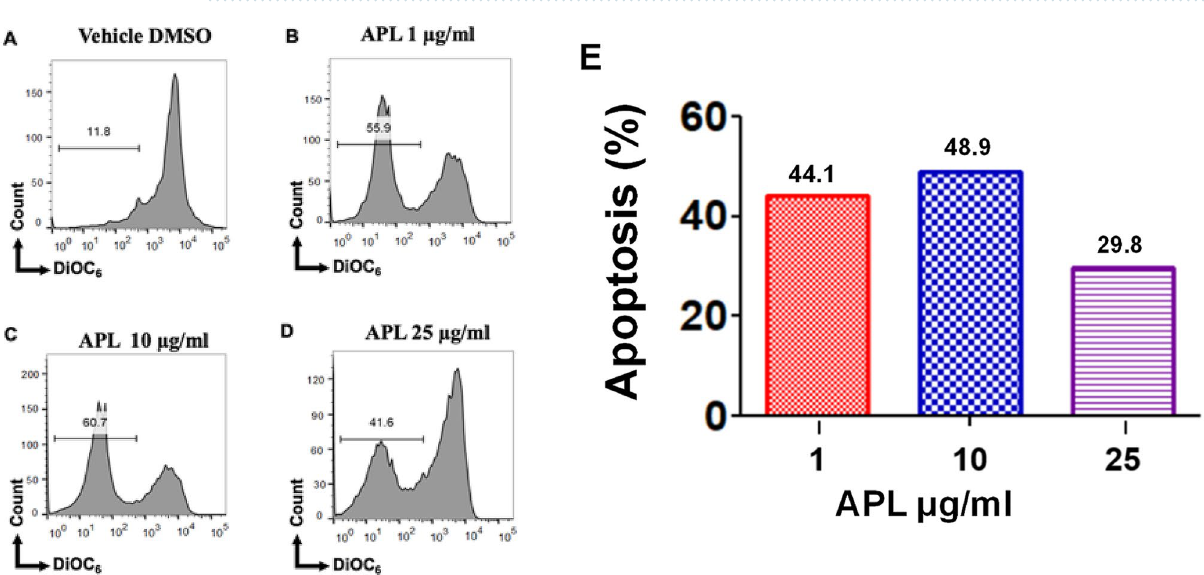
Figure 9. Effect of APL treatment on mitochondrial membrane potential (MMP) in B16 melanoma cells: This was determined using 3,3 ′ -Dihexyloxacarbocyanine Iodide (DiOC6) after treatment with APL ( Psiadia lithospermifolia ) or vehicle (DMSO). ( A ) (vehicle DMSO), ( B ) (1 µg/ml), ( C ) (10 µg/ml), ( D ) (25 µg/ml) of APL extract. The data presented are representative of three independent experiments. ( E ) shows data as mean % apoptosis relative to vehicle controls from two independent